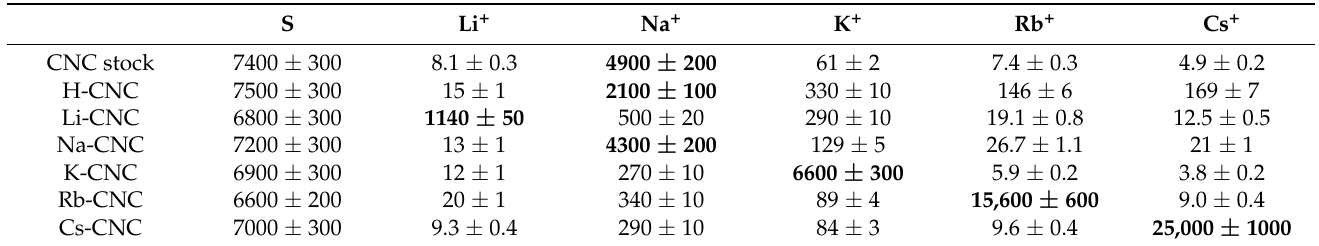
Table 1. Elemental composition (mg/kg) of the stock CNCs, and the H-CNCs treated with alkali metal salts.